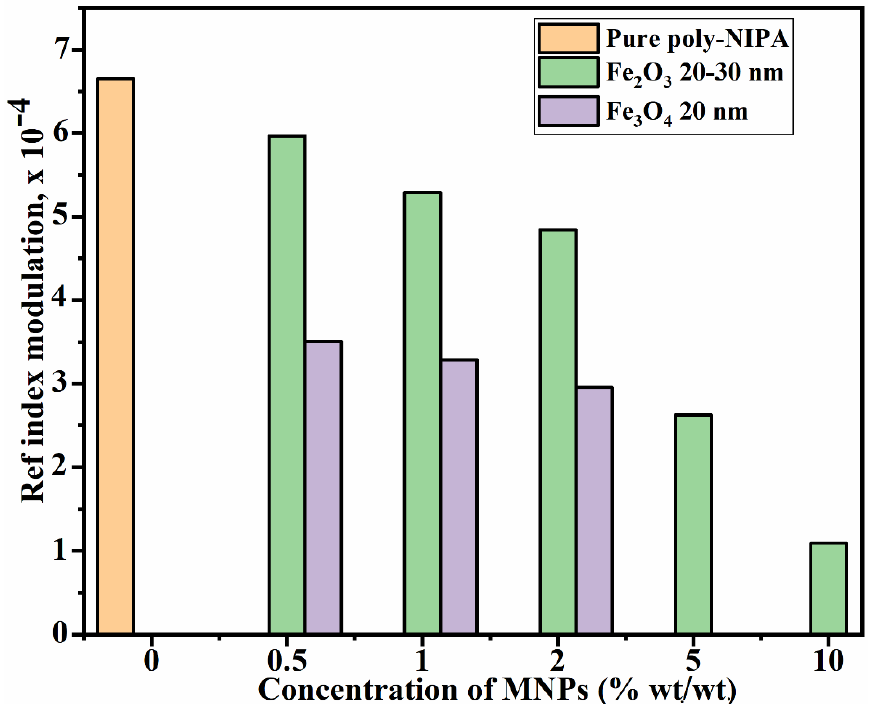
Figure 6. Refractive index modulation (RIM) vs concentration of MNPs in the dry layer of nanocom- posites having Fe 2 O 3 Alpha (average size 20 – 30 nm) and Fe 3 O 4 (average size 20 nm).